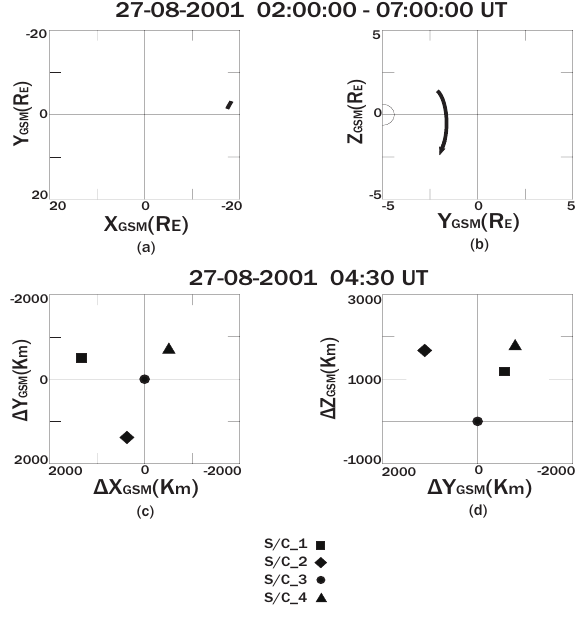
Fig. 2. Cluster trajectory between 02:00 and 07:00 UT in differ- ent plane projections, together with the relative position of the four spacecraft in the X–Y and Y–Z planes, in GSM